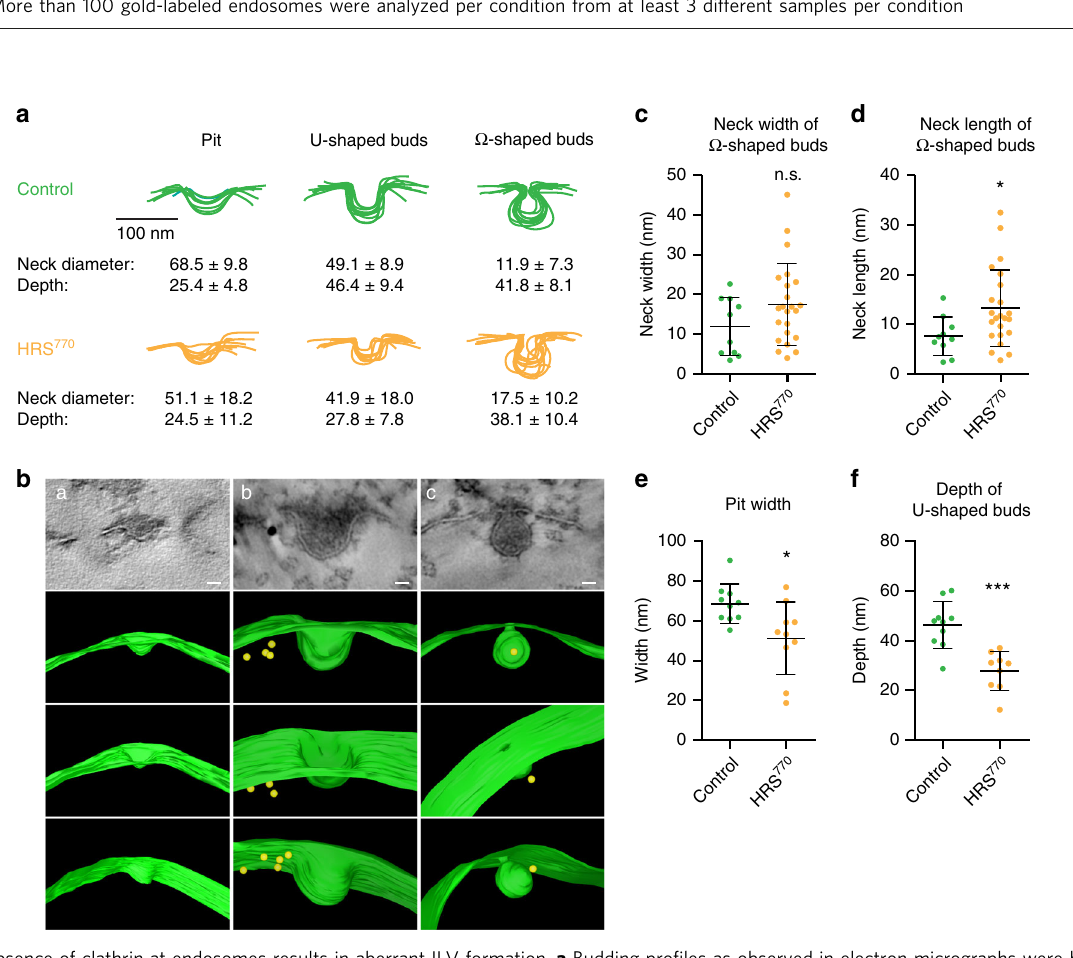
Fig. 7 Endosomal clathrin is required for EGFR degradation, cargo sorting and ef fi cient ILV formation. a mCherry-HRS 770 does not rescue EGFR degradation upon depletion of endogenous HRS. Experiment was done side by side with Supplementary Fig. 3E,F. Mean ± SD from three experiments. t -test, *** p < 0.001. b Stably expressing HeLa cells as indicated were depleted for endogenous HRS as shown in Fig. 5b and processed for EM as described in Supplementary Fig. 4A. The 10 nm gold particles mark internalized EGFR after 60 min of EGF stimulation. Note that in HRS wt -expressing cells gold particles can be found as clusters inside degradative organelles, indicating degradation of gold-labeled EGFR. In contrast, in HRS 770 -expressing cells the gold-labeled EGFR is still found in the limiting membrane, where it covers a large portion of the surface, indicating impaired cargo sorting. Scale bar, 200 nm and 50 nm (inset). c Stably expressing HeLa cells as indicated were depleted for endogenous HRS as shown in Fig. 5b and processed for EM as described in Supplementary Fig. 4A. The 10 nm gold particles mark newly internalized EGFR after 15 min of EGF stimulation. Asterisks denote ILVs (40 – 60 nm diameter), arrowheads the boundaries of an endosomal EGFR/HRS/clathrin (HRS wt ) or EGFR/HRS (HRS 770 ) coat. Note the complete absence of this electron density in the absence of HRS (left panel). Scale bar, 500 nm and 100 nm (inset). d Quanti fi cation of the number of ILVs per endosome section. Data represented as dot plots with mean ± SD. Kruskal – Wallis test: p < 0.0001; Dunn ’ s multiple comparison test: *** p < 0.001, n.s. not statistically